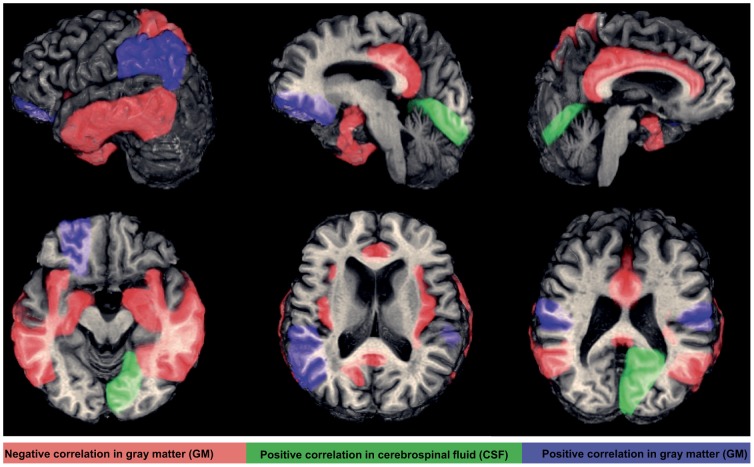
The brain regions associated with Multi-Scale GV.Higher glycemic variability of GVC1–3 (period 0.5–2 hours) were associated with lower gray matter (GM) volume (red color; both hemispheres in the cingulate gyrus, hippocampal gyrus, middle and inferior temporal gyrus, insular cortex, the left superior parietal gyrus and right fusiform gyrus), greater GM volume (blue color; the bilateral supramarginal gyrus, left angular gyrus and left middle orbitofrontal gyrus), and greater cerebrospinal fluid (CSF) in the right lingual gyrus (green color).